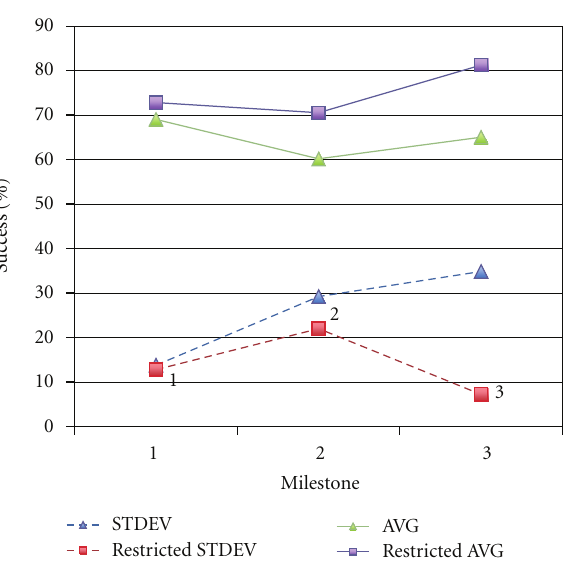
Figure 11: Results (% success) from milestones 1 and 2.